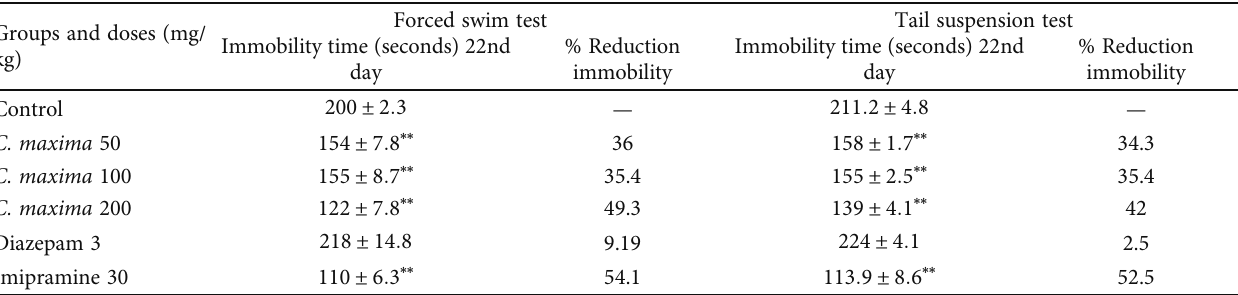
Figure 5: The outcome of C. maxima seeds in OFT. Table 10: E ff ect of C. maxima seed extracts on depression by forced swim test and tail suspension